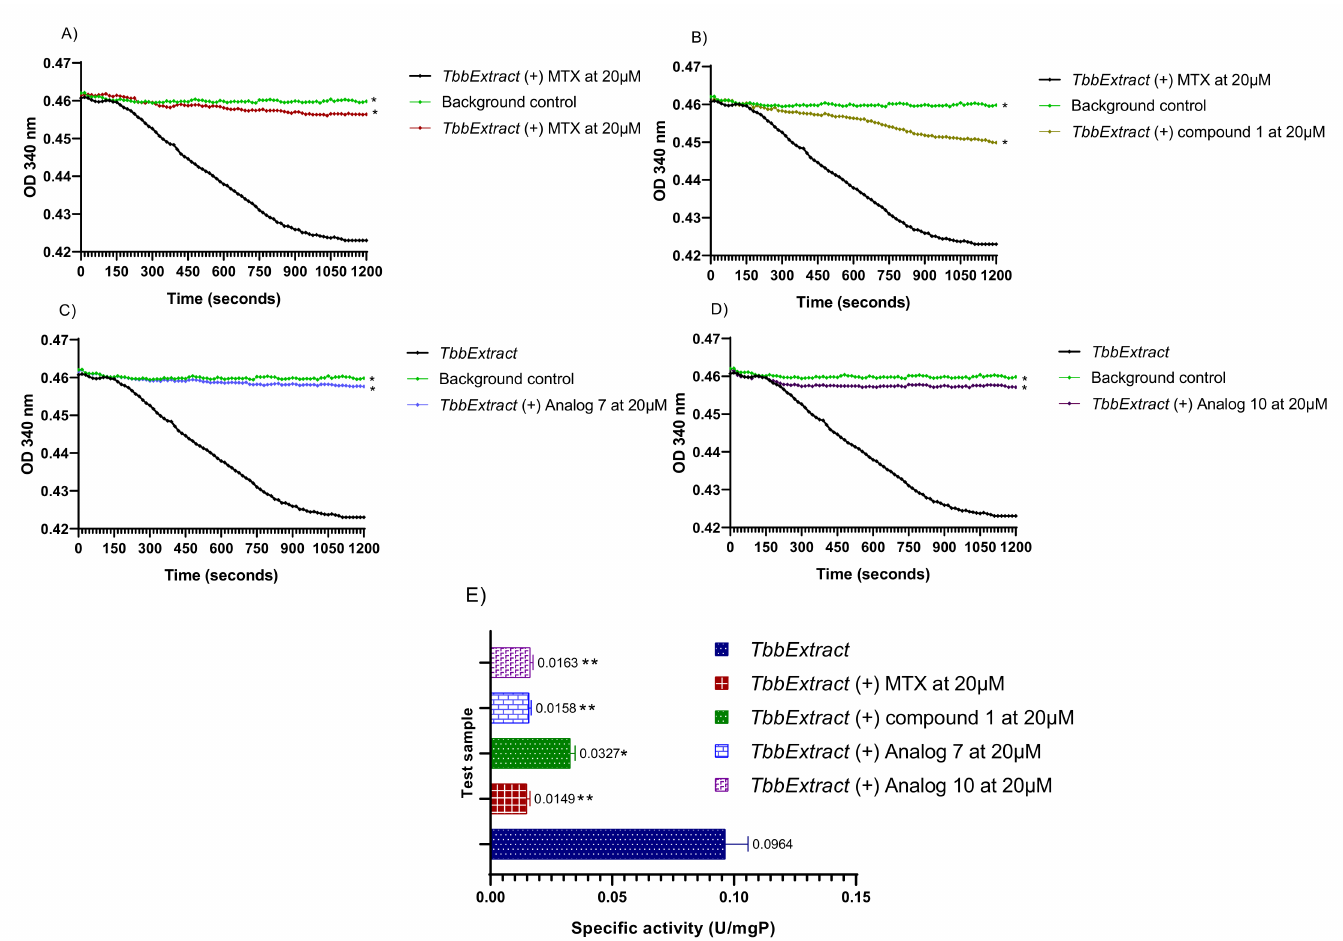
Figure 6. Measurement of the T. b. b. lysate protein activity. The decrease in absorbance was moni- tored at 340 nm in a kinetic mode for 20 min at room temperature. The obtained optical densities were plotted versus time using GraphPad Prism 8.0 to generate the rate of substrate consump- tion in the presence of Methotrexate ( A ), parent compound 1 ( B ), analog 7 ( C ) and analog 10 ( D ). Protein-specific activities were deduced in presence or absence of the test inhibitors at a single concentration of 20 µ M ( E ). T. b. b. Extract: Crude protein extract of Trypanosoma brucei brucei ; MTX: Methotrexate; Compound 1 : Parent hit MMV675968; Analog 7 : MMV1578467; Analog 10 : MMV1578445. The results are expressed as mean ± standard deviation of two independent experi- ments performed in duplicate. Mean values superscripted with (*) indicate statistically significant difference with the T. b. b. protein extract control at p < 0.05 and (**) indicate statistically significant difference with the T. b. b. protein extract control at p < 0.001 as given by the Tukey’s multiple comparison